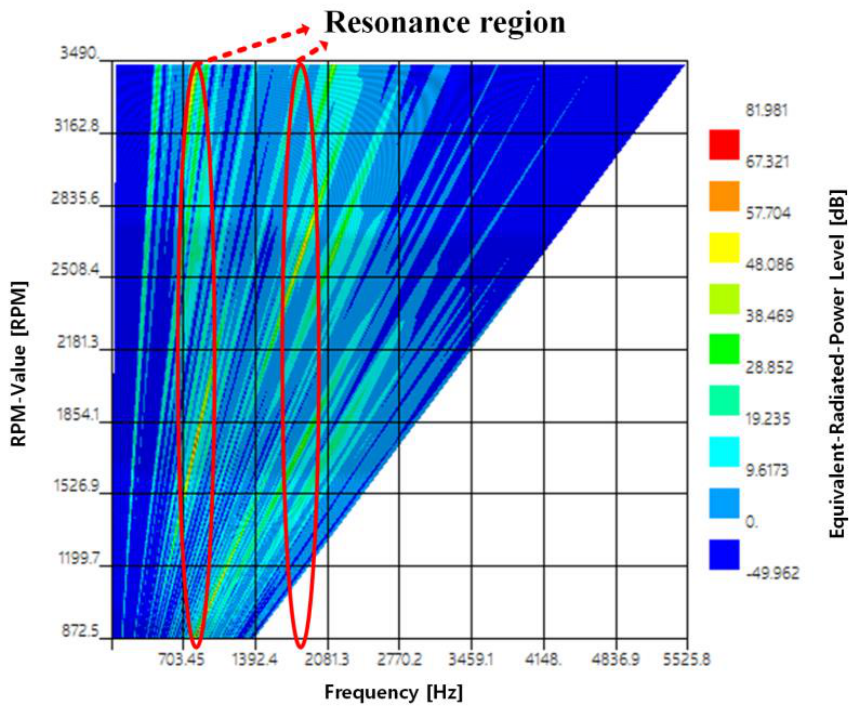
Figure 10. NVH Analysis result.